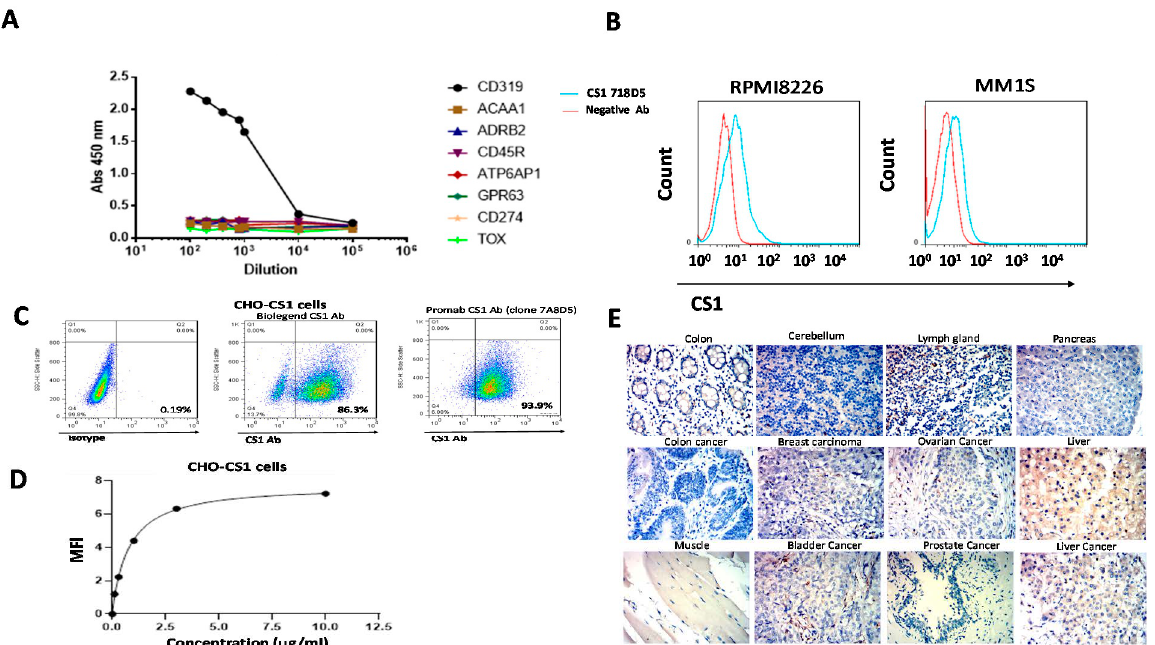
Figure 1. The CS1 (clone 7A8D5) antibody binds the CS1 protein. ( A ) ELISA shows binding to the CS1 antigen but not negative control proteins by the anti-CS1 antibody clone 7A8D5. ( B ) The CS1 antibody binds multiple myeloma cells by FACS. ( C ) The CS1 antibody detects CS1 in CHO-CS1 stable cell line. The commercial CS1 antibody control also bound CS1 ( Biolegend Clone 162.1). ( D ) Binding affinity by titration of the CS1 antibody using CHO-CS1 cells. The representative curve is shown. The Kd of binding was equal to 0.8 ug/mL or 5.3 nM. ( E ) IHC staining with the CS1 antibody showed positive staining in lymph gland and negative staining in most normal and tumor tissues.